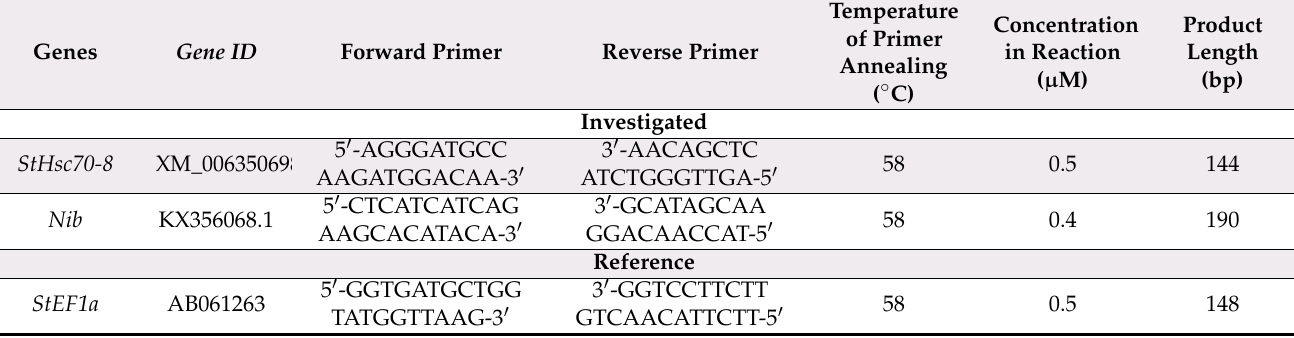
Table 1. Gene accession numbers, primer sequences, and product lengths for RT-qPCR analyses.